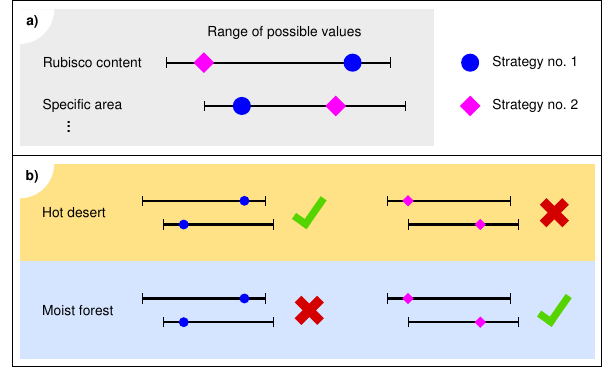
Figure 4: Generation of physiological strategies and their survival. a) Many random param- Fig. 4. Generation of physiological strategies and their survival. eter combinations (strategies) are sampled from ranges of possible values. The strategies are then run in each grid cell of the model. b) Example: In a hot desert, strategy 1 survives, (a) Many random parameter combinations (strategies) are sampled because a small specific area reduces water loss by evaporation and a high Rubisco content from ranges of possible values. The strategies are then run in each is adequate to high light intensities. Strategy 2, however, dies out since too much water evaporates due to a large specific area. In a moist forest, strategy 1 dies out because a grid cell of the model. (b) Example: In a hot desert, strategy 1 sur- high Rubisco content is associated with high respiration costs which cannot be covered by vives because a small specific area reduces water loss by evapora- low light conditions under a canopy. Strategy 2 can survive since it does not have high respiration costs. Note that these examples are not generally applicable. High specific area, tion and a high Rubisco content is adequate to high intensities of for instance, could also be useful in a desert to collect dew. light. Strategy 2, however, dies out since too much water evapo- The 15 model parameters which are included in the random sampling method are listed rates due to a large specific area. In a moist forest, strategy 1 dies in Table B.9 in the appendix. They represent structural properties of the thallus of a out because a high Rubisco content is associated with high respi- lichen or bryophyte, such as specific area or water storage capacity. They also describe ration costs which cannot be covered by low light conditions under implications of the thallus structure, such as the relation between water content and water potential. Furthermore characteristics of the metabolism are considered, such as 270 a canopy. Strategy 2 can survive since it does not have high respi- optimum temperature. Also parameters which have categorical values are used: a lichen ration costs. Note that these examples are not generally applicable. or bryophyte can either live in the canopy or at the soil surface (see Sect. 2.1.1). Another High specific area, for instance, could also be useful in a desert to categorical parameter determines if the organism has a carbon concentration mechanism collect (CCM) or not. For the model, it is assumed that the CCM in lichens works similarly